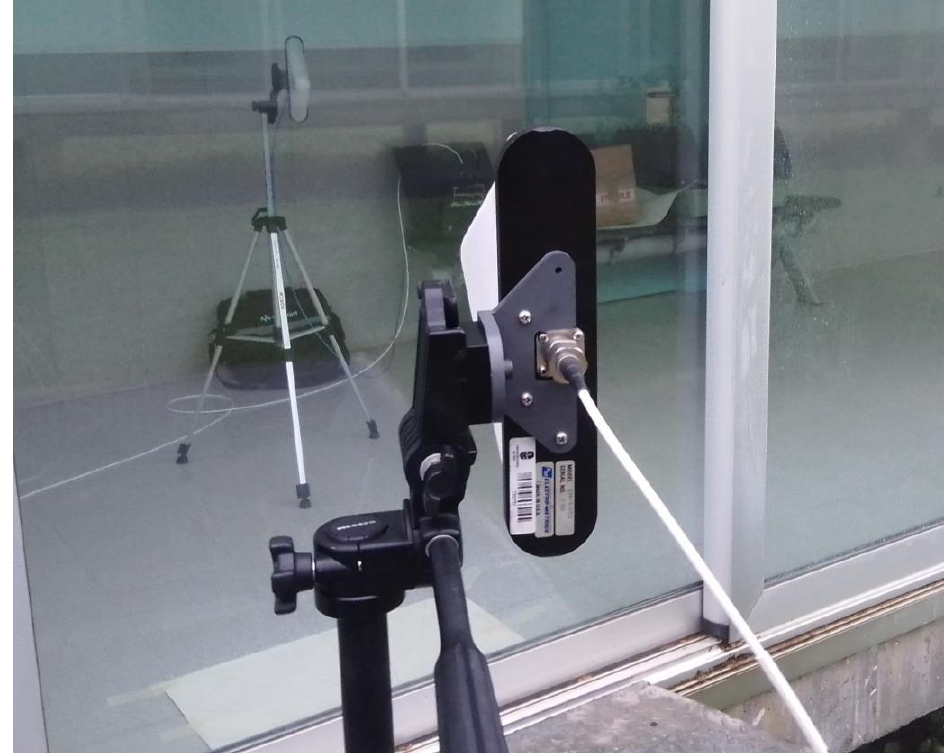
Figure 12. Glass façade.